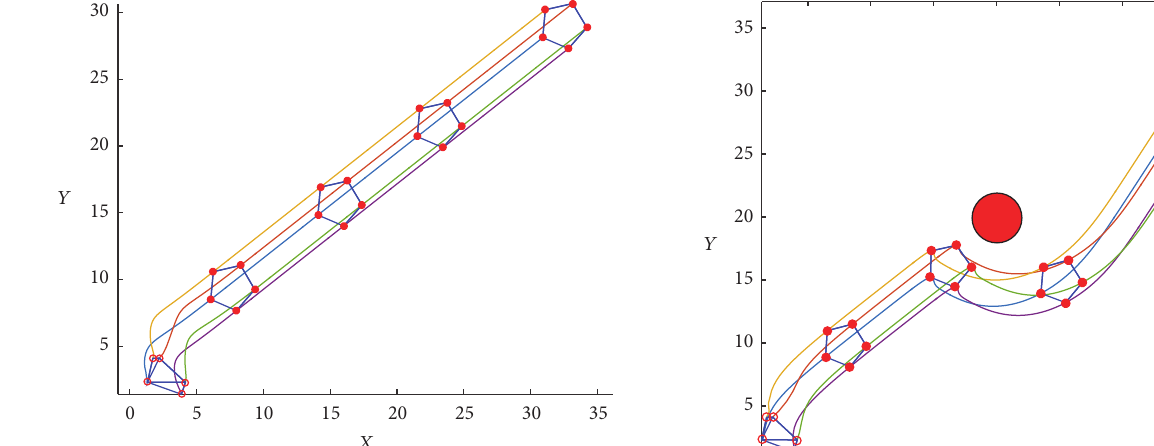
flocking without obstacle in the configuration workspace.